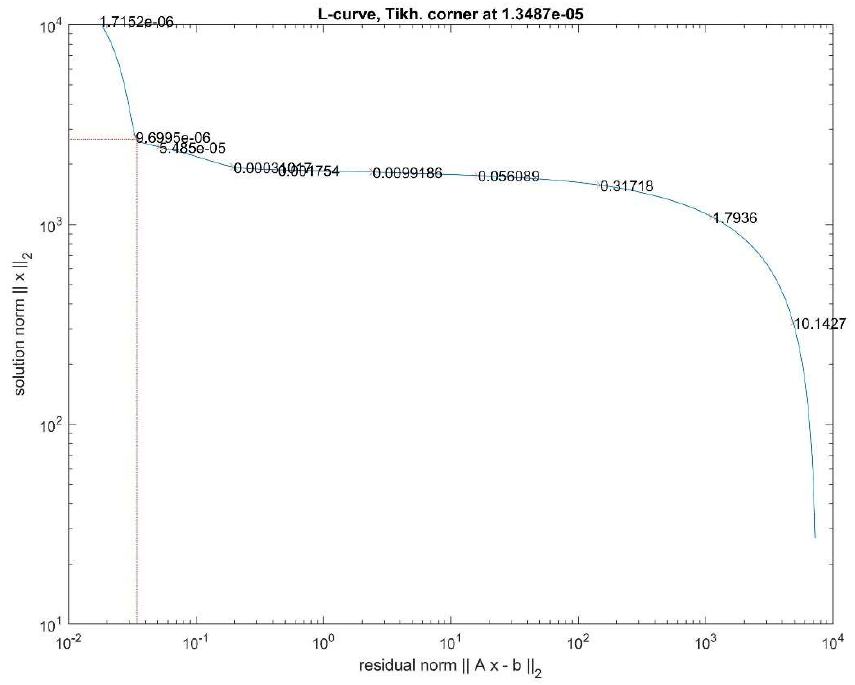
Figure 6. The L-Curve method for determining the smoothing parameter.